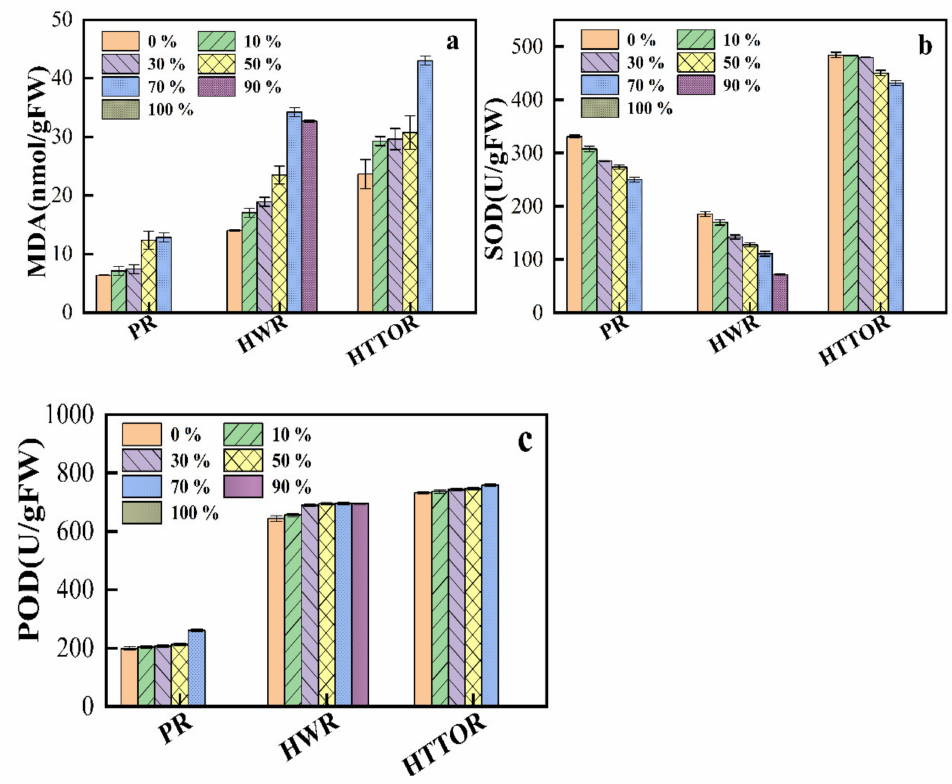
Figure 4. Effect of heat treatment residues on the enzymatic activity of mung beans. ( a ) the content of malondialdehyde; ( b ) the content of superoxide dismutase; ( c ) the content of peroxide dismutase. When the three residues examined herein were at higher concentrations, the MDA and peroxidase content in the mung beans increased gradually, whereas SOD content decreased gradually. These results indicate that the residues caused a certain degree of plant membrane damage, resulting in an imbalance between oxidation and antioxidation in the plants. Higher residue concentrations resulted in aging, lodging, and other adverse effects after 14 days. This might be due to the inhibition or degradation of plant enzymes caused by the heavy metals in the